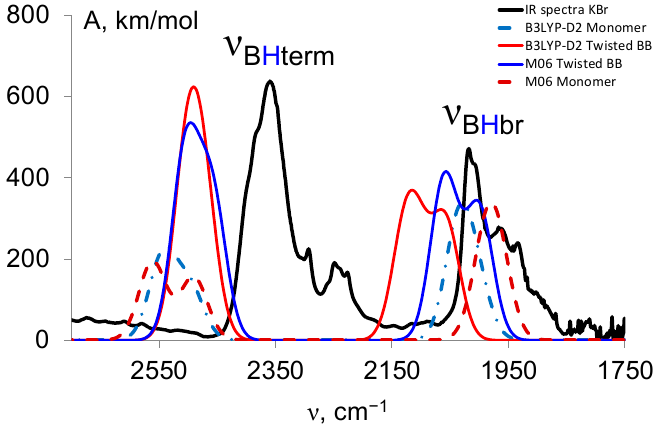
Figure 6. Experimental IR spectra of [( μ 2 -dppm) 2 Cu 2 ][ η 2 -BH 4 ] 2 and simulated IR spectra of M06 and B3LYP-D2 optimized ( η 1 -dppm)Cu( η 2 -BH 4 ) monomer and 1 . No scaling factors applied.